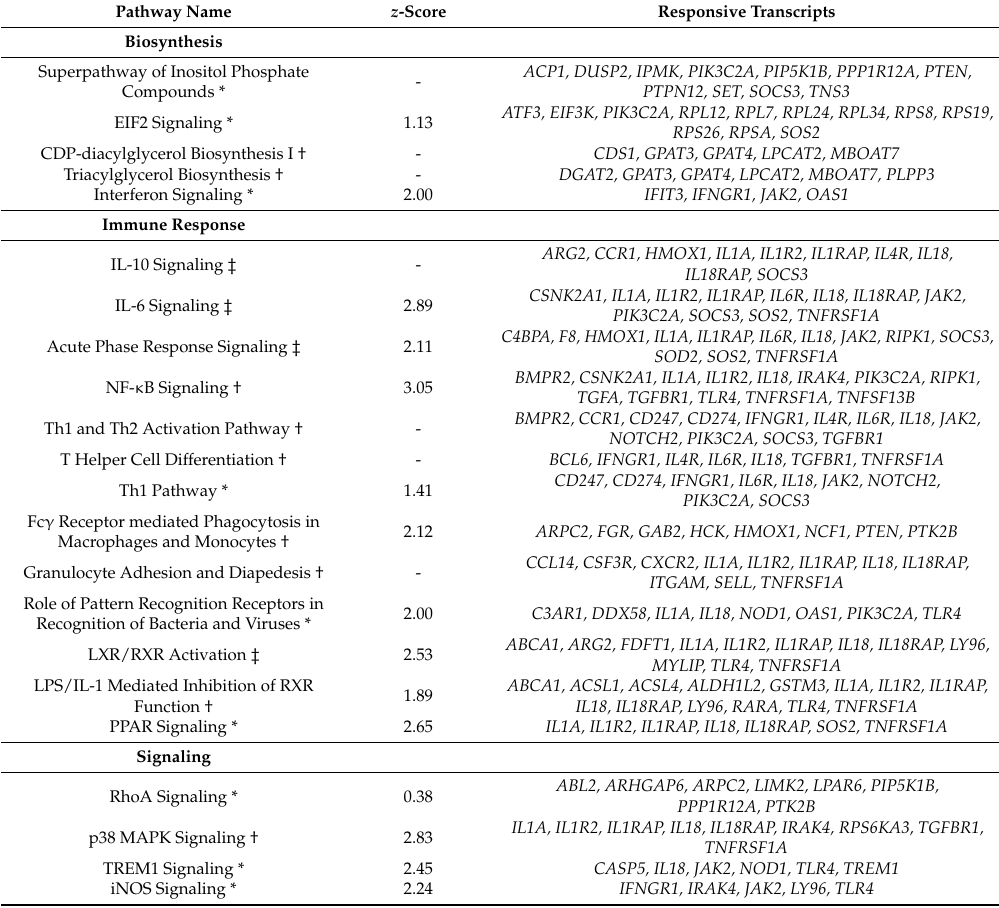
Table 2. Excerpt of pathways altered in PBMC of piglets fed diets with low and high amounts of P and Ca. Pathways were selected for affiliation with immune response, biosynthesis, and signaling. A full list of pathways is displayed in Table S4.